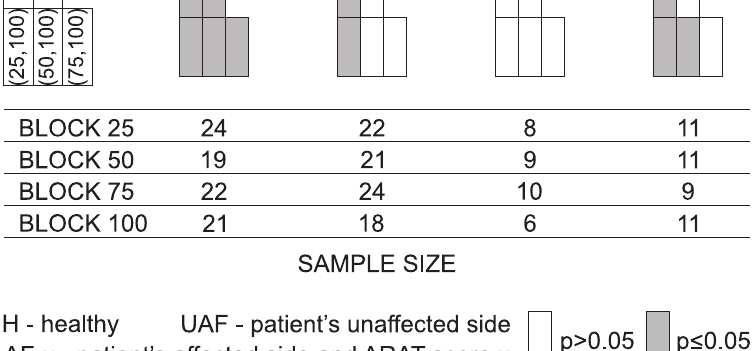
Figure 10. Statistical significance for muscle activity ˆ w n for four grasp tasks. Four blocks: Side length i 25 mm, 50 mm, 75 mm, and 100 mm during the transfer phase. Presented groups are: H, healthy (first matrix); UAF, patient’s unaffected side (second matrix); AF-A3, patient’s affected side with Score 3 (third matrix); and AF-A2, patient’s affected side with Score 2 (fourth